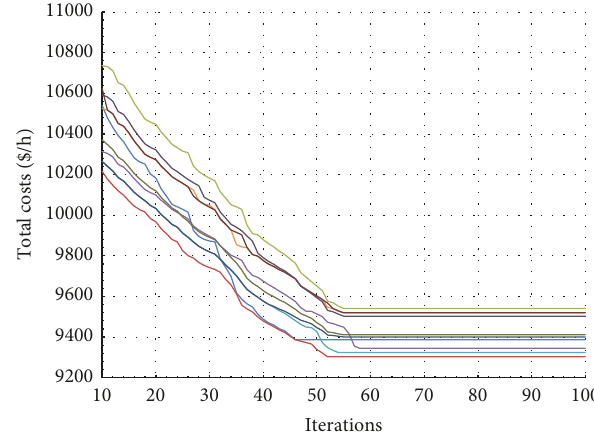
Figure 5: Result of each iteration.